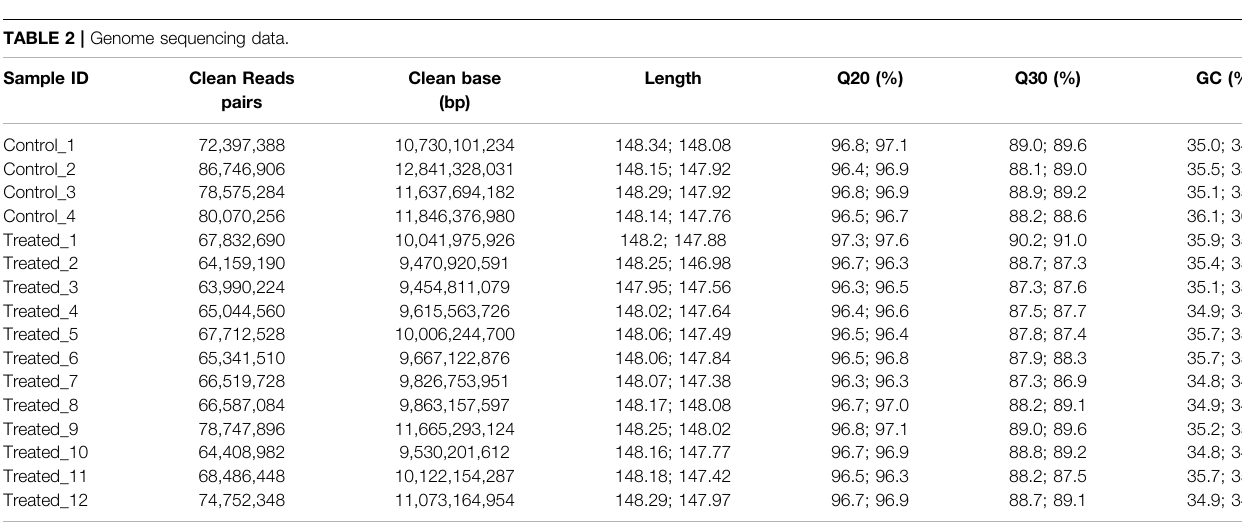
TABLE 2 | Genome sequencing data.